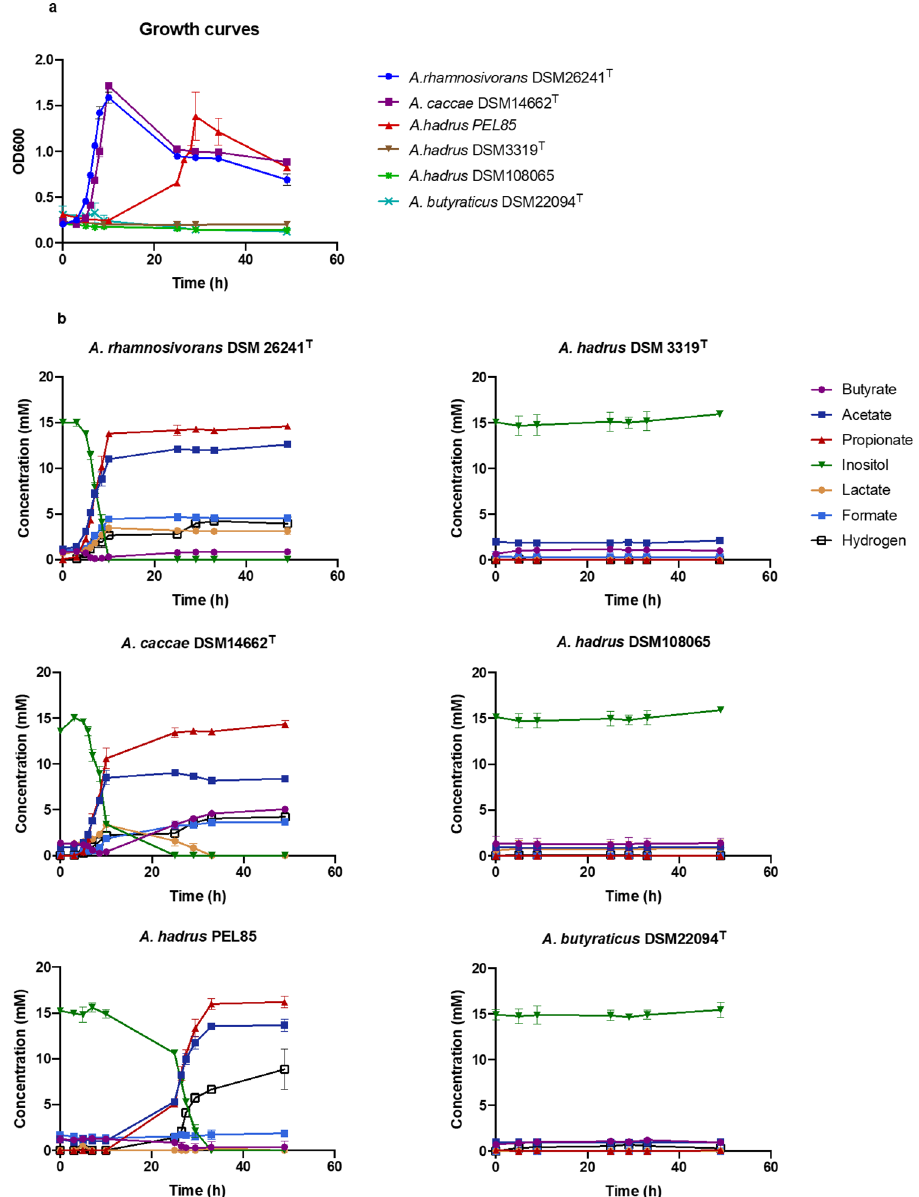
Fig. 1 Metabolite production from myo -inositol by Anaerostipes strains. The growth was performed in bicarbonate-buffered medium supplemented up to 15 mM myo -inositol as substrate. a Growth curves ( n = 3 biological replicates); b Metabolite production and substrate consumption by 6 Anaerostipes strains ( n = 3 biological replicates). Data are presented as mean values